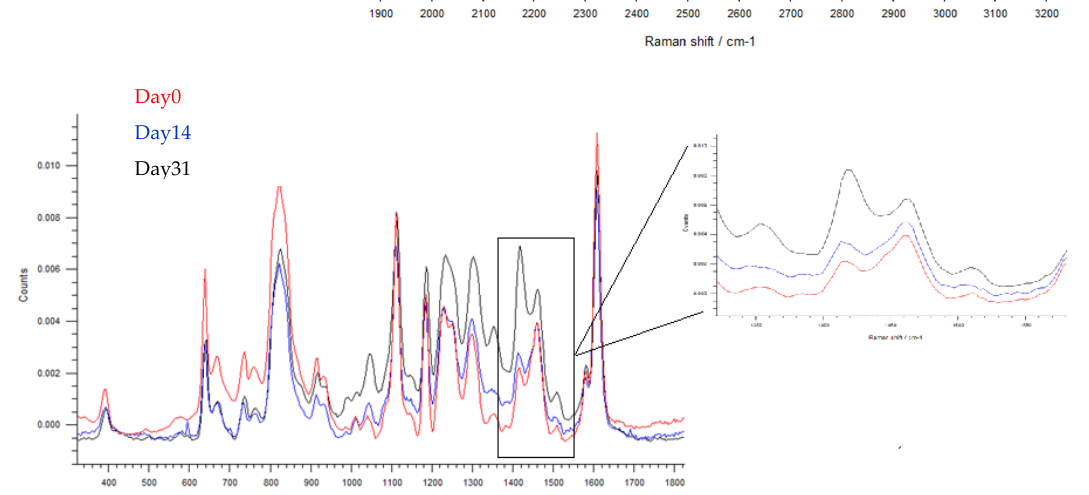
Figure 14. Comparison of the Raman Spectrum of the resin at different aging times for the area between 1800–3200 cm − 1 (top) and between 300–1800 cm − 1 (bottom).